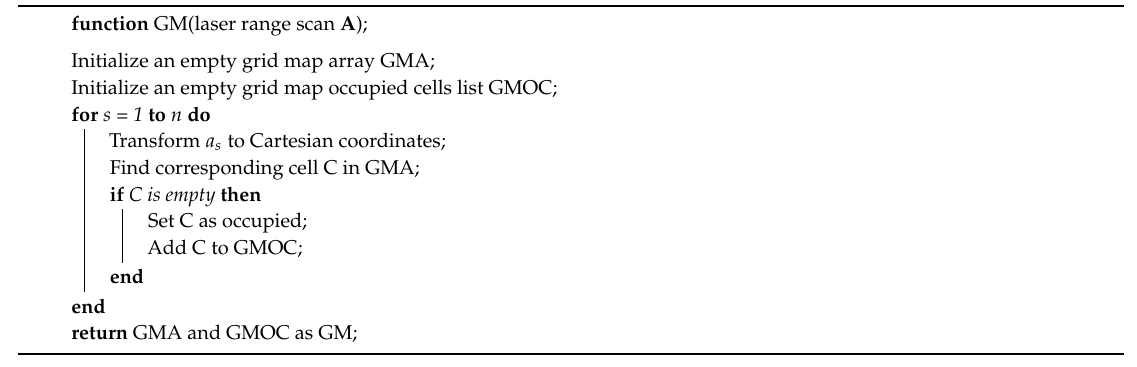
Algorithm 2: Pseudocode of grid map composition.